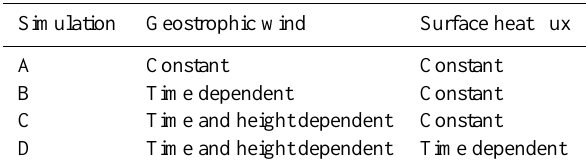
Table 1. Applied forcing in simulations A, B, C and